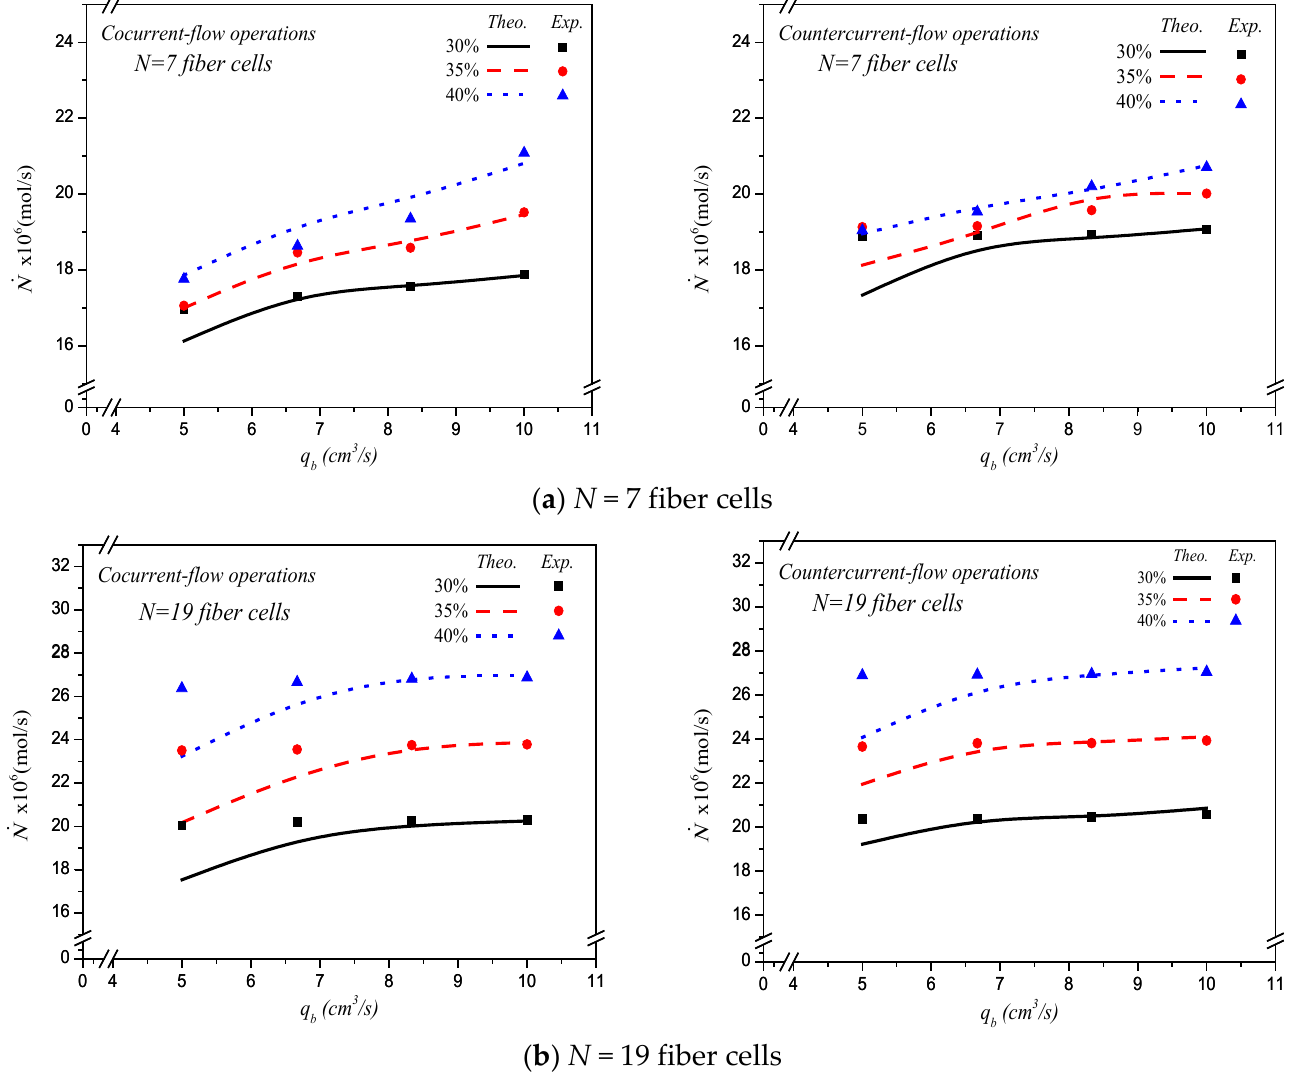
Figure 9. Effects of MEA flow rate and various fiber cells on CO 2 absorption flux. The absorption flux in the device with embedding various fiber cells are presented graphically for N = 1, N = 7, and N = 19, respectively, as delineated in Figure 10, with the number of fiber cells, inlet feed CO 2 concentration, and flow pattern as parameters under both cocurrent- and countercurrent-flow operations. The increase of both MEA feed flow rate and the number of fiber cells yielded a higher absorption rate, but the absorption fluxes decreased with the number of fiber cells, as seen in Figure 10.